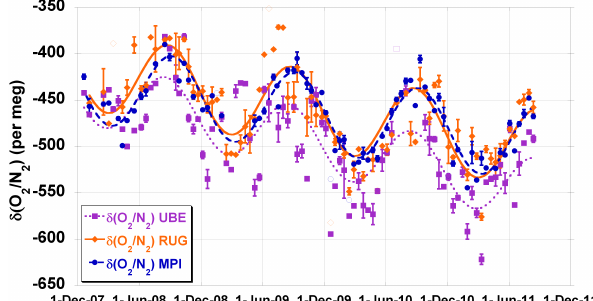
Fig. 5. Differences of the δ (O 2 /N 2 ) values measured by each pair of two laboratories. The average differences are: − 33 per meg for UBE-RUG, − 31 per meg for UBE-MPI and − 3 per meg for MPI- RUG. The error bars represent the quadratically added standard er- rors of the measurements of the two